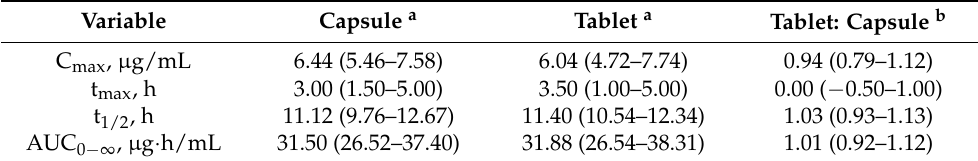
Table 4. Plasma pharmacokinetic variables of setipiprant in healthy subjects after administration of